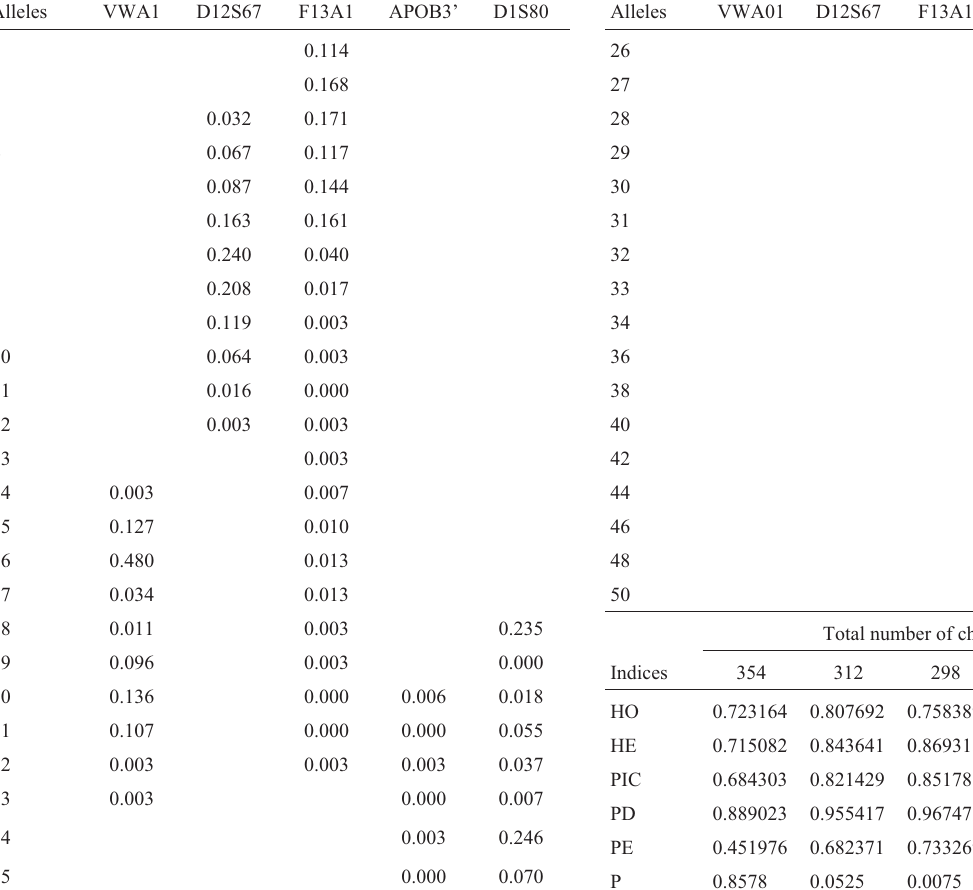
Table 1 - Allele frequencies and variability measures at the five loci analyzed in the São Luís population.